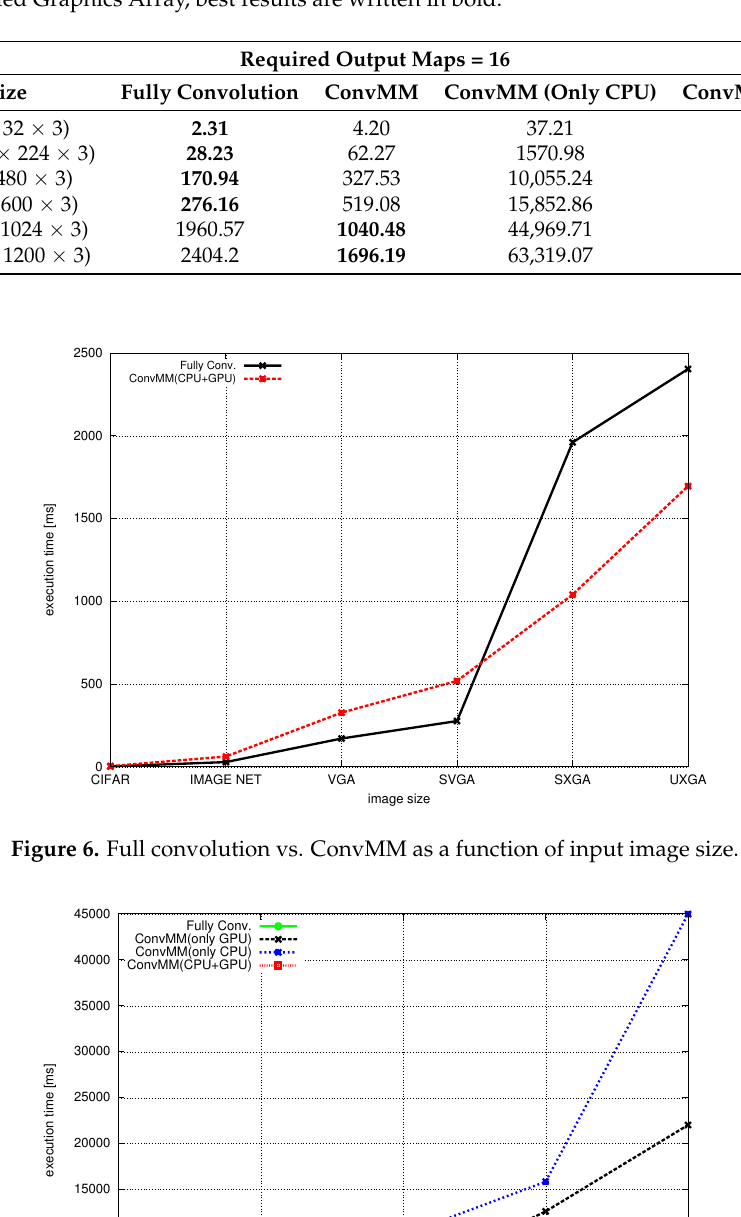
Table 3. Execution time of the convolution layers under various computational loads (ms) CIFAR: Canadian Institute For Advanced Research database; ImageNet: ImageNet database; VGA: Video Graphics Array; SVGA: Super Video Graphics Array; SXGA: Super eXtended Graphics Array; UXGA: Ultra eXtended Graphics Array, best results are written in bold.